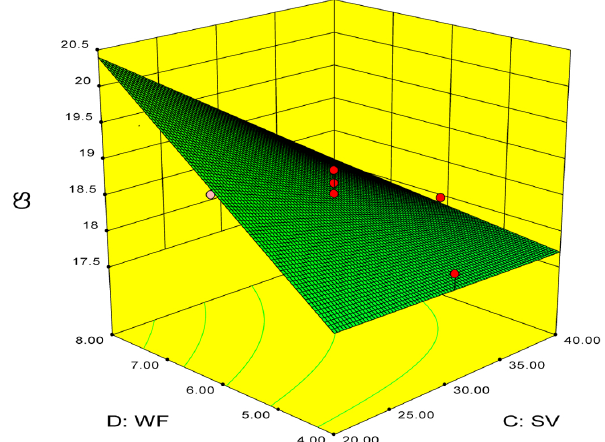
Figure 7a. Combined e ff ects of T on and T o ff on